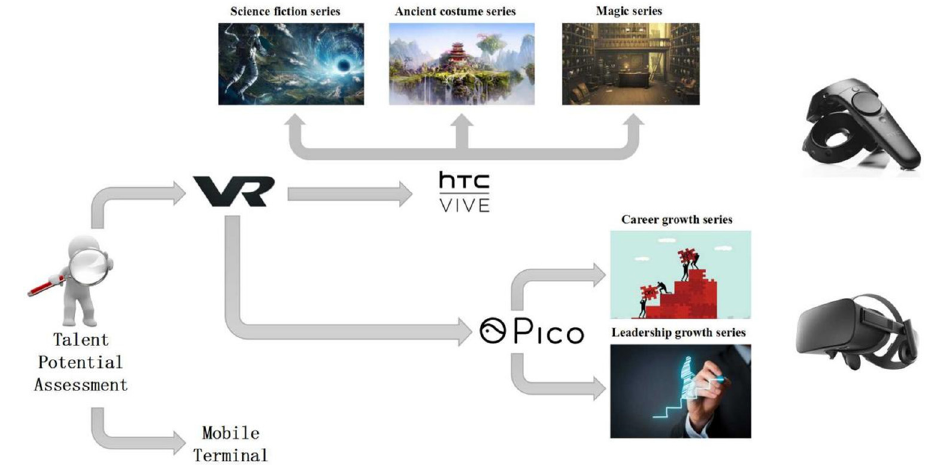
Figure 1: VR system fl